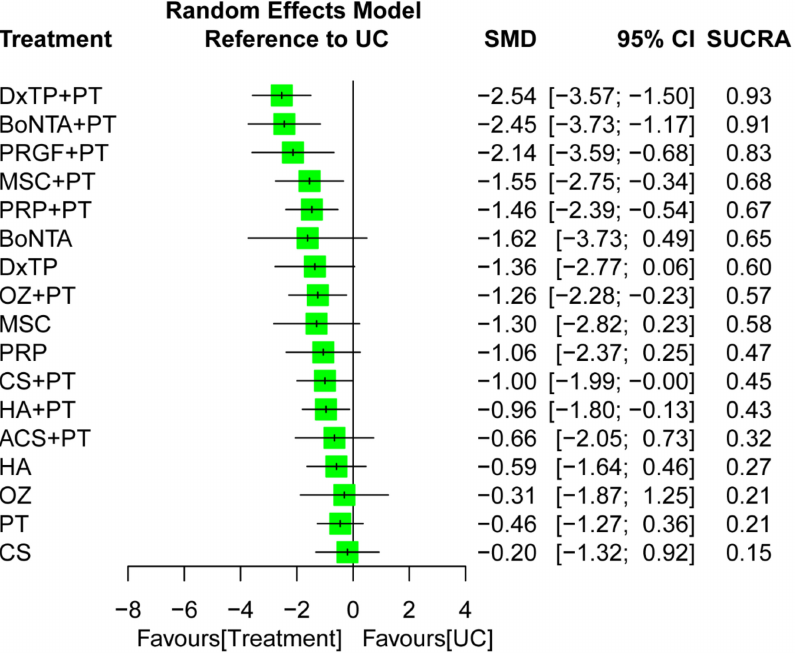
Figure 3. Forest plot summarizing the effects of treatment regimens on pain reduction for the entire follow-up duration. SMD, standardized mean difference; CI, confidence interval; SUCRA, surface under the cumulative ranking curve; ACS, autologous conditioned serum; BoNTA, botulinum toxin type A; CS, corticosteroid; DxTP, dextrose prolotherapy; HA, hyaluronic acid; MSC, mesenchymal stem cell; OZ, ozone; PRP, platelet-rich plasma; PRGF, plasma rich in growth factor; PT, physical therapy; UC, usual